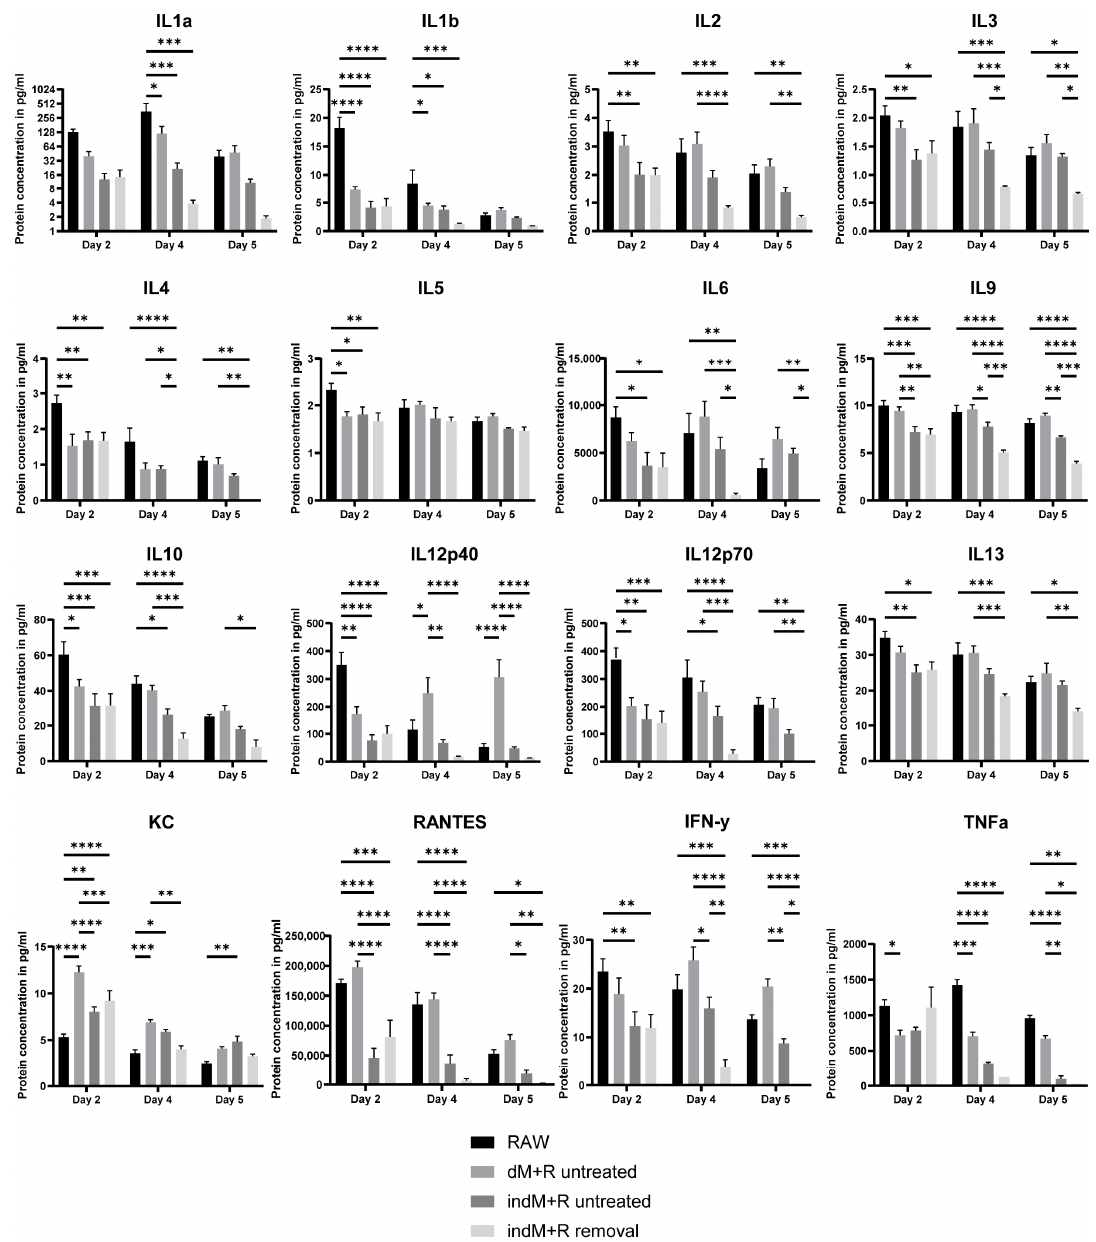
Figure 5. Luminex assay for direct and indirect co-culture of intestinal organoids with macrophages. Pro- and anti-inflammatory cytokines were produced upon direct and indirect co-culture of organoids with RAW 264.7 cells over a period of 5 days. Removal of RAW 264.7 cells was performed after 3 days of co-culture. Data are presented as the mean ± SEM ( n = 4). ****, ***, **, and * for p < 0.0001, p < 0.001, p < 0.01, and p < 0.05, respectively. Abbreviations: RAW, RAW 264.7 cells; dM + R, direct co ‐ culture; indM + R, indirect co ‐ culture.